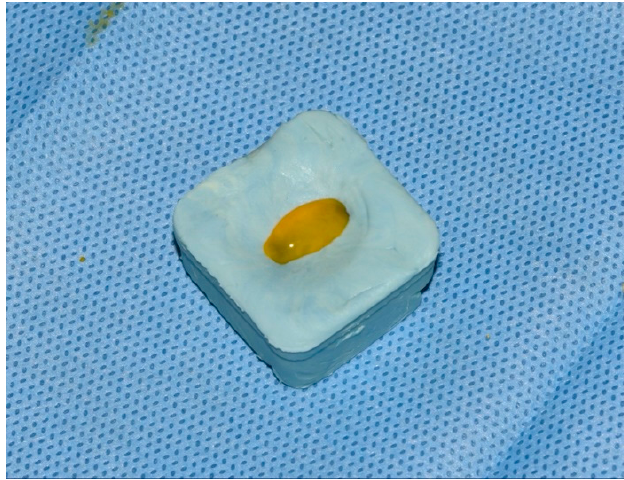
Figure 4. Treatment of implant with 0.1% riboflavin dye for 60 s.